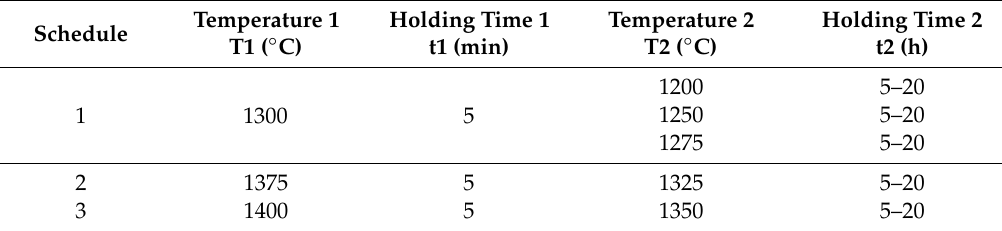
Figure 6. Density of samples after two-step sintering vs. second step sintering time t2. Table 1. Two-step sintering schedules of samples prepared from as-received powder.